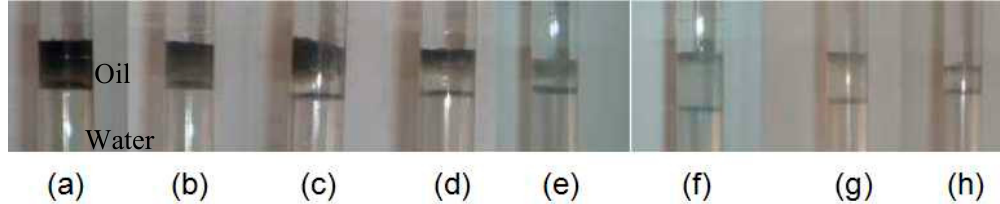
Figure 5. The suspend situation of Ru-Zn(x)/m-ZrO 2 catalysts in the oil phase after catalytic experiments: ( a ) Ru/m-ZrO 2 AH; ( b ) Ru-Zn(0.06)/m-ZrO 2 AH; ( c ) Ru-Zn(0.33)/m-ZrO 2 AH; ( d ) Ru-Zn (0.47)/m-ZrO 2 AH; ( e ) Ru-Zn(0.60)/m-ZrO 2 AH; ( f ) Ru-Zn(0.69)/m-ZrO 2 AH; ( g ) Ru-Zn (0.86)/m-ZrO 2 AH; ( h ) Ru-Zn (1.02)/m-ZrO 2 AH.